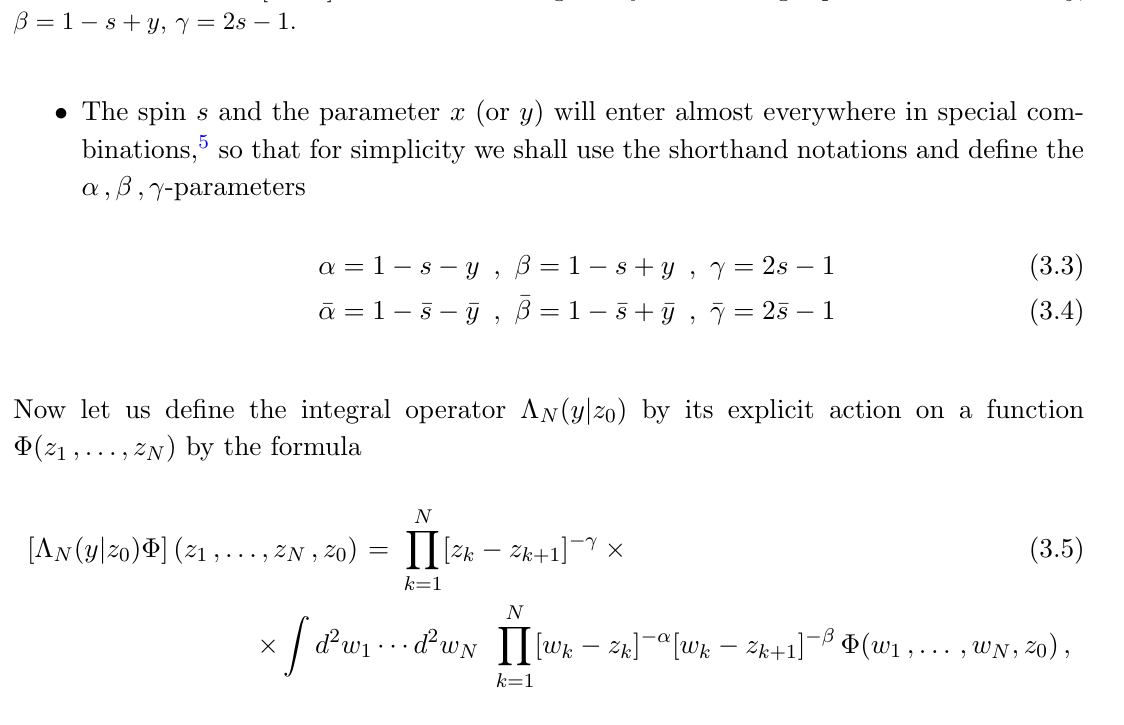
s y , (cid:0) (cid:0)